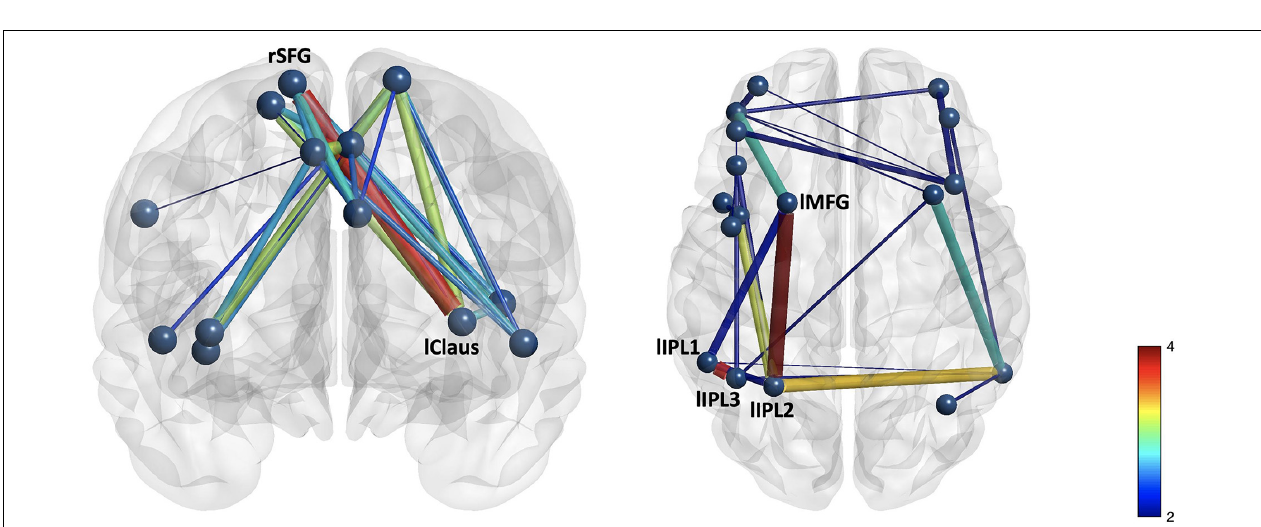
FIGURE 2 | Group differences in (A) cingulo-opercular and (B) frontoparietal networks demonstrate stronger connectivity in the control group than in the mTBI group. The edge with the largest group difference in the CO network was the right superior frontal gyrus–left claustrum [ t (103) = 3.76, p < 0.001, red]. Edges with the largest group differences in the FP network were the left inferior parietal lobule 1–left inferior parietal lobule 3 [ t (103) = 3.73, p < 0.001], and left middle frontal gyrus 1–left inferior parietal lobule 2 [ t (103) = 3.96, p < 0.001].